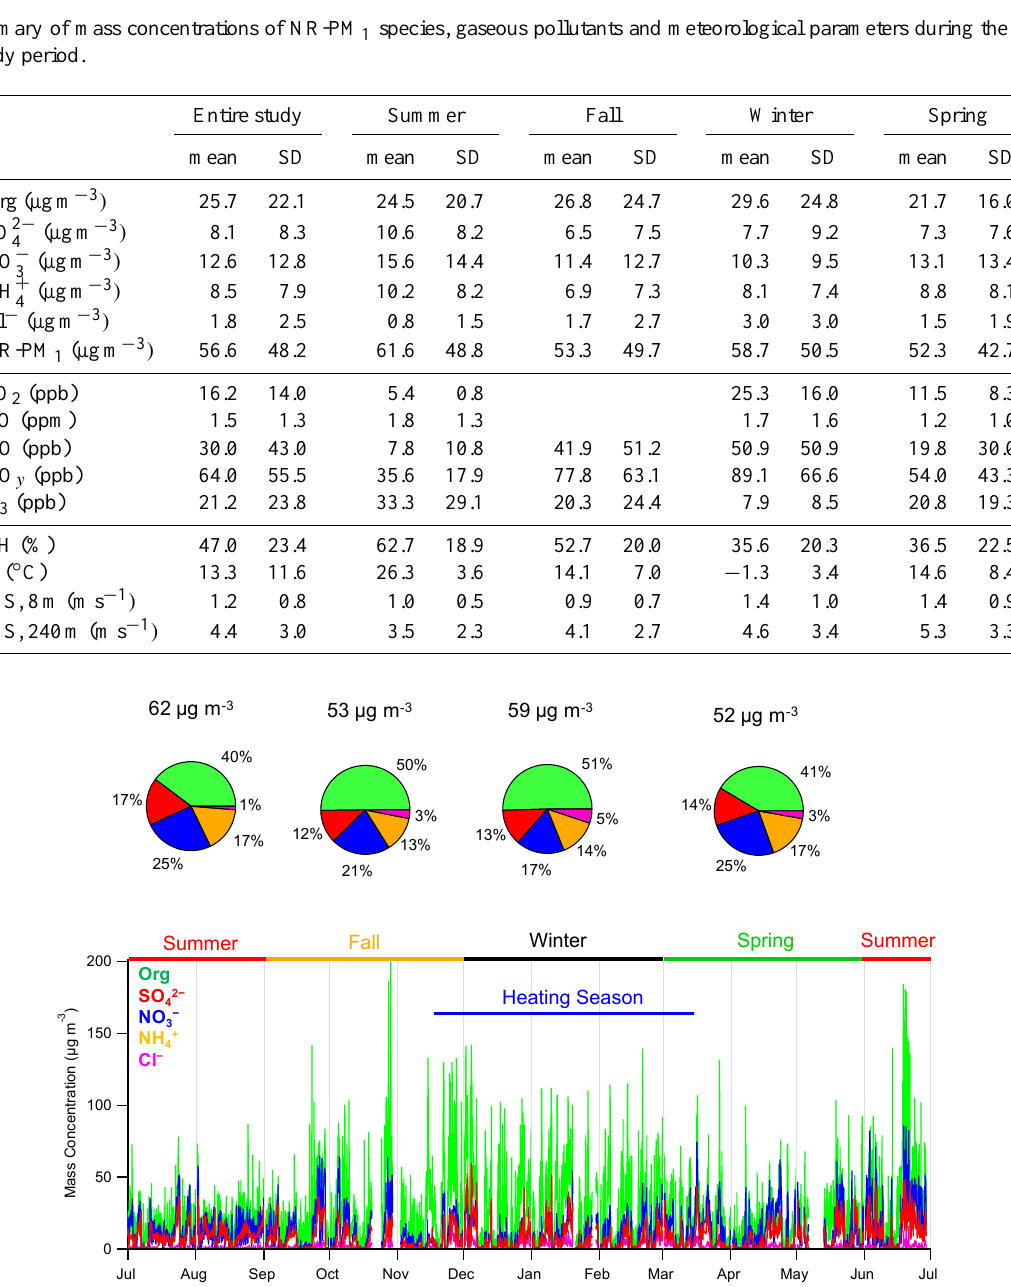
Figure 3. Time series of NR-PM 1 species for the entire year. The pie charts show the average chemical composition of NR-PM 1 during the four seasons (summer, fall, winter, and